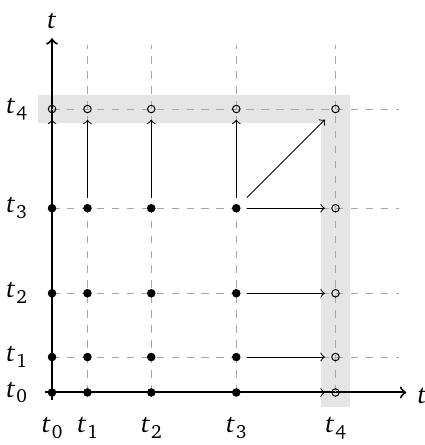
Figure 3: Time-stepping procedure for Eq.